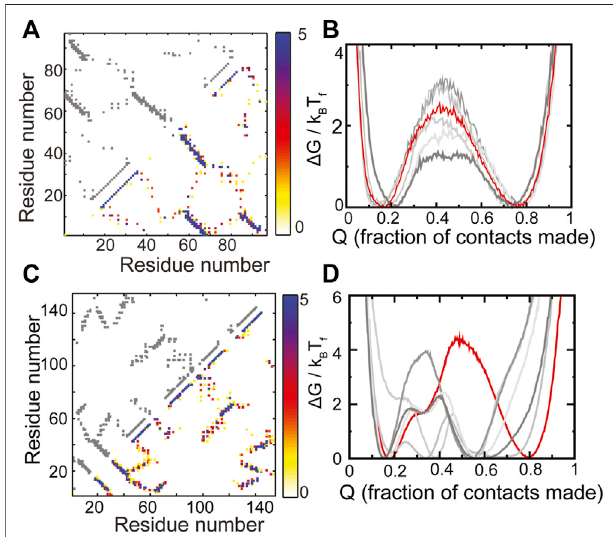
FIGURE 3 | RPs of evolved proteins show diverse properties. (A,B) S6 (C,D) ecoRNase-H. (A,C) The contact map of the WT is shown in grey in the upper left triangle. The composite contact map of fi ve RPsof the protein is showninthelowerrighttriangle.ThecolorrepresentsthenumberofRPs that a given contact is present in with the color scale being given on the right. (B,D) Scaledfreeenergies oftheWT(red)andthe fi veRPs(differentshadesof grey)areplottedasafunctionofthefractionofnativecontactsoftheindividual proteins. (B) S6 folds like the Ferredoxin protein ( Figures 2C , 4F ). No intermediate (a dip in the barrier) is populated and the unfolded and the folded ensembles are similar across the WT and the RPs. (D) ecoRNase-H behaves differently from S6. The FEP of the WT is mostly cooperative with only two populated minima, none of the RPs fold completely and several intermediates are populated. Thus, although nature seems to have evolved an optimal packing, this packing is special and not reproducible in an RP. Panels (A) and (B) contain replotted data from our previous work (Yadahalli and Gosavi, 2014; Copyright 2013 by John Wiley and Sons, Adapted with